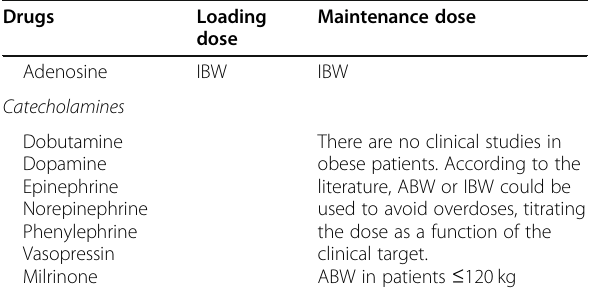
Table 2 Emergency drug dosing in obese patients. Adapted from Cataldo et al. [72] (Continued)